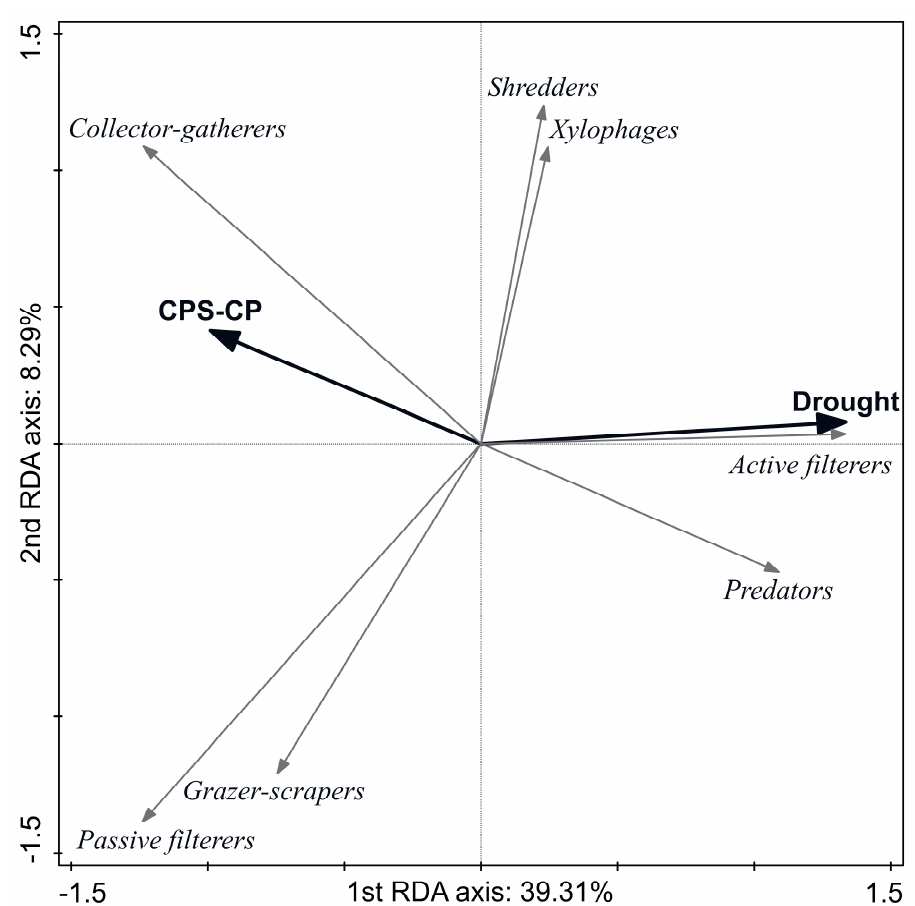
Figure 3. Ordination diagram showing the relationships between the average functional feeding groups (FFGs) represented by solid grey arrows and disturbances (CPS-CP = chlorpyrifos-cypermethrin contamination estimated from the chlorpyrifos sediment contamination and Drought = drought status; see Materials and Methods) represented by solid black arrows. Both disturbances have significant ( p < 0.05) power to predict the FFG composition. Arrow length corresponds to the quality of fit. The FFG was extrapolated from abundances of all detected organisms (CPS-CP: explained variation 25.3%, pseudo-F = 3.1; Drought: explained variation 22.3%, pseudo-F = 3.4, respectively; adjusted variation explained by both predictors = 34.50%).